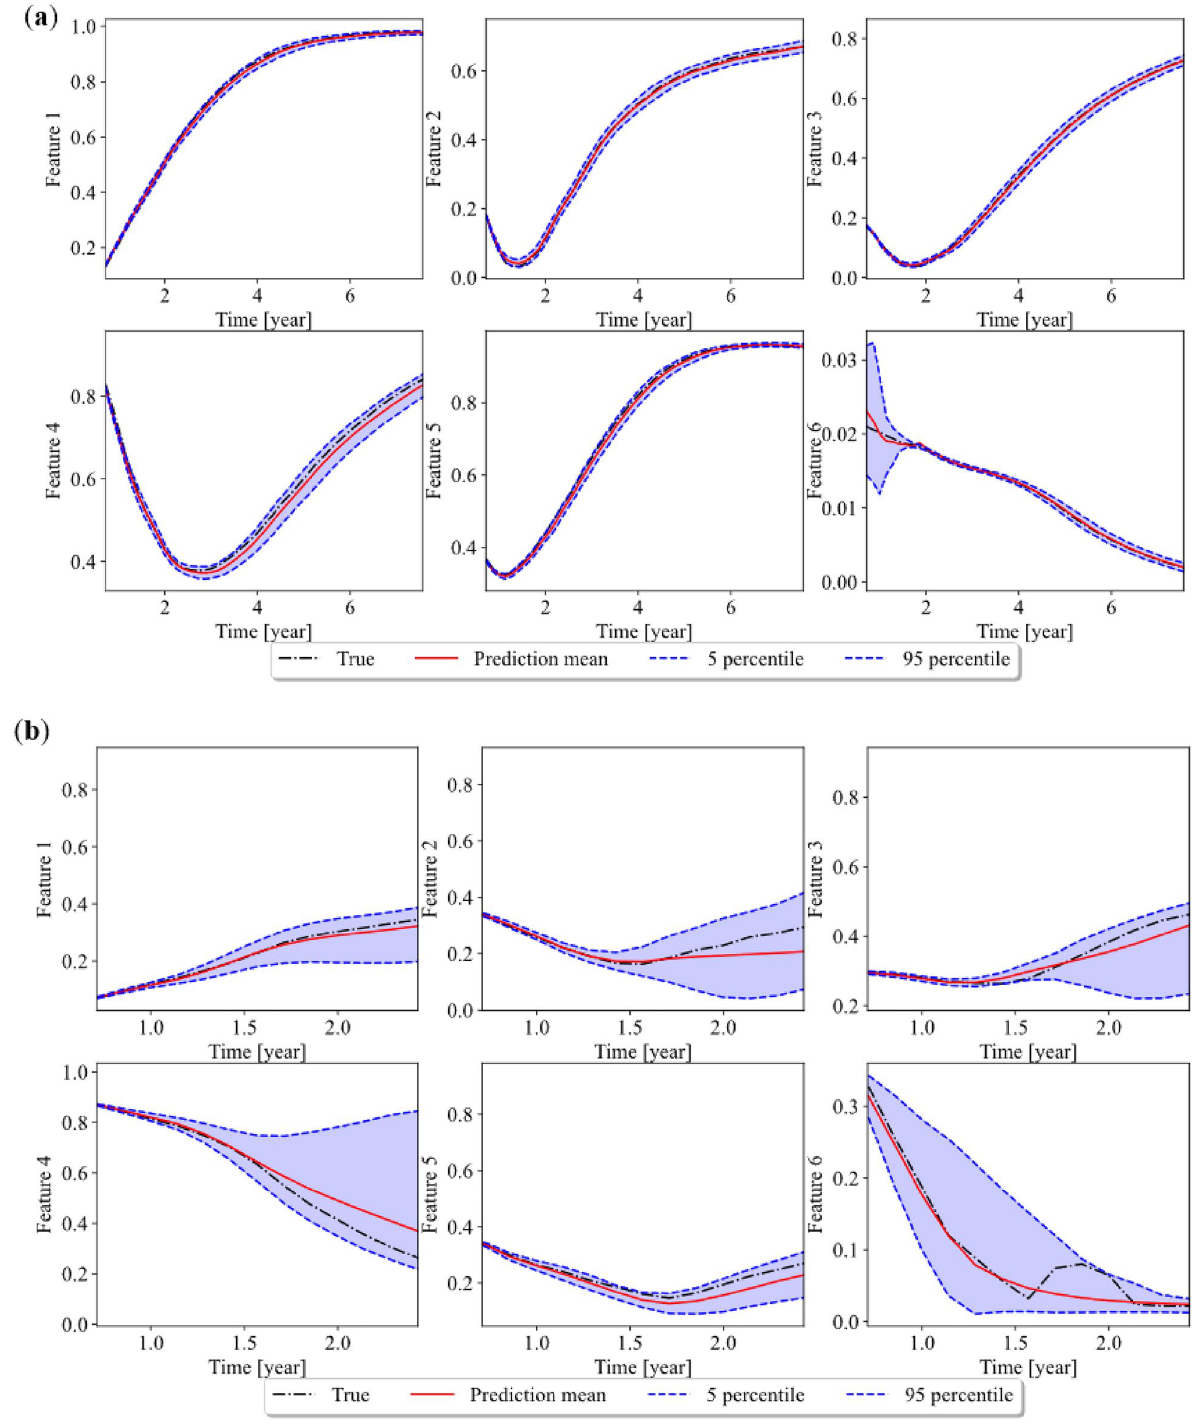
Figure 16. Multi-step ahead prediction result of case ( a ) and ( b ) in the latent